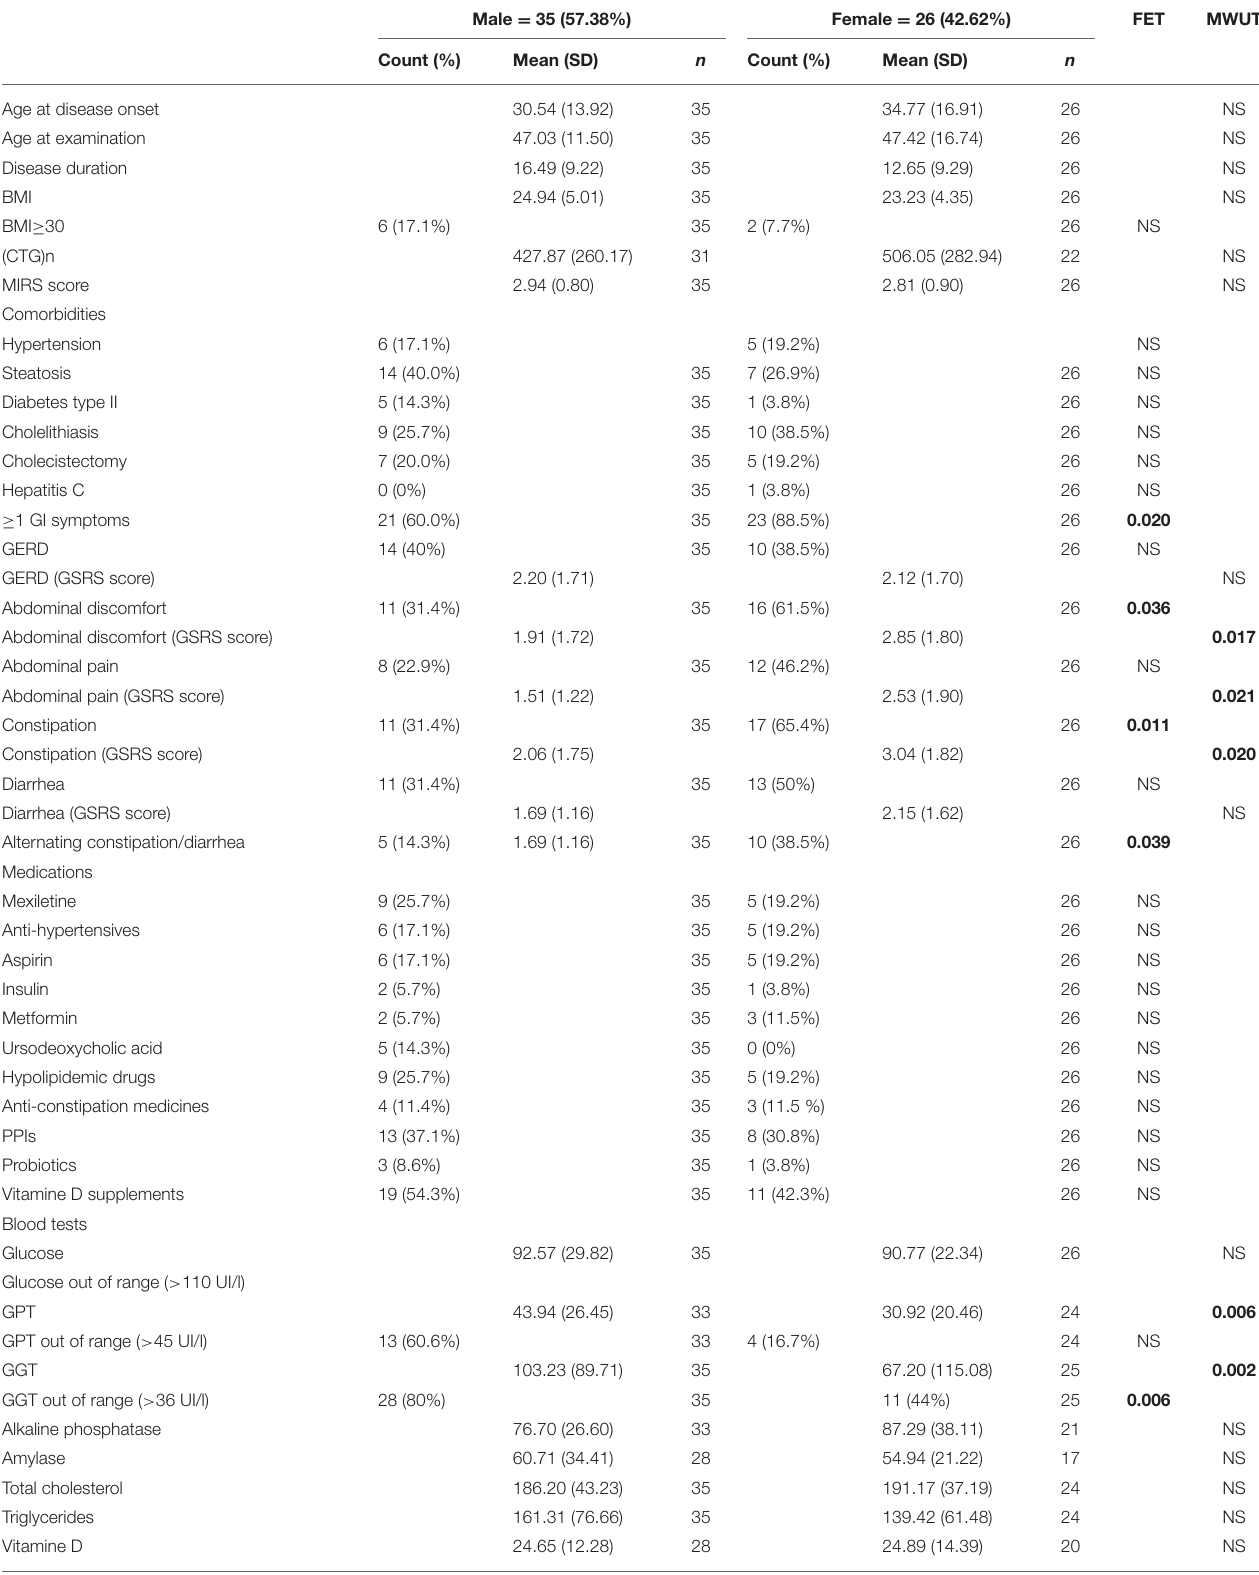
TABLE 2 | Statistical analysis for gender-related